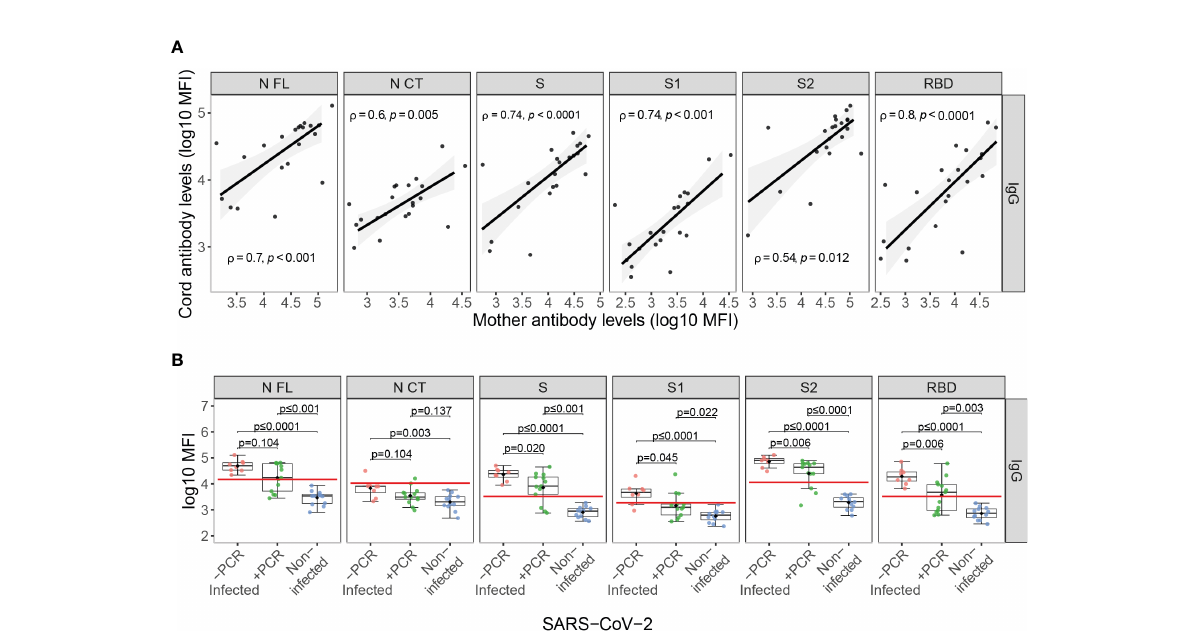
FIGURE 3 Anti-SARS-CoV-2 antibody levels in cord blood. (A) Correlations of anti-SARS-CoV-2 IgG levels (log 10 median fl uorescence intensity, MFI) in paired infected mothers and cord blood samples represented as a linear model with standard error as con fi dence interval (shaded areas) and assessed by the Spearman test, showing the rho ( r ) and p-values. (B) Comparison of anti-SARS-CoV-2 IgG cord blood levels (log 10 MFI) between infected mothers who tested COVID-19 rRT-PCR positive (+PCR, N=13, in green) during the third trimester, those that tested rRT-PCR negative (-PCR, N=8, in red) and from non-infected mothers (N=12, in blue). The boxplots represent the median (bold line), the mean (black diamond), the 1 st and 3 rd quartiles (box) and the largest and smallest values within 1.5 times the inter-quartile range (whiskers). Groups were compared by the Wilcoxon-rank-sum-test. The red line indicates the seropositivity cutoff calculated as 10 to the mean plus 3 standard deviations (SD) of log 10 -transformed MFI of 129 pre-pandemic controls. Antigens: nucleocapsid full-length (N FL) and C-terminus (N CT), spike full-length (S), S1 and S2 subunits, and receptor-binding domain